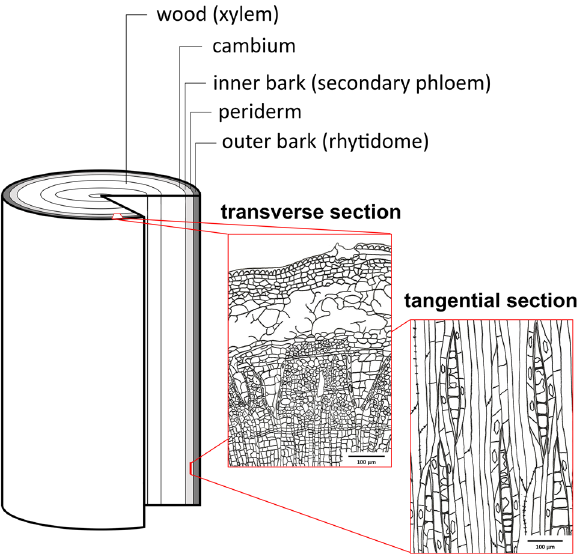
Figure 1. Schematic illustration of the bark and two exemplary drawings from transverse and tangential section of Tilia